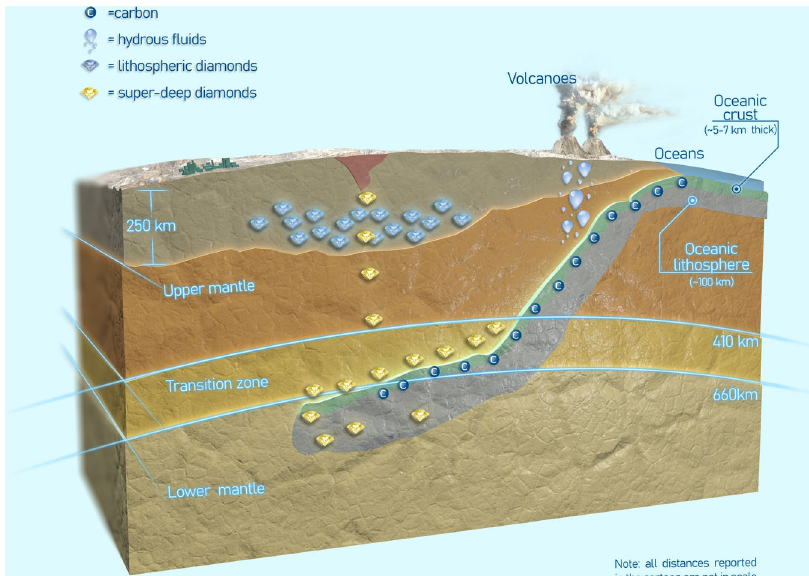
Fig. 1 Diamonds journey through the Earth ’ s interior. Cartoon showing the growth zones for lithospheric diamonds (the fi rst 250 km of depth) and super- deep diamonds (410 – 700 km depth). The grey part indicates a subducting slab that can penetrate into the lower mantle at depths greater than 660 km (cartoon by F. Chirico).